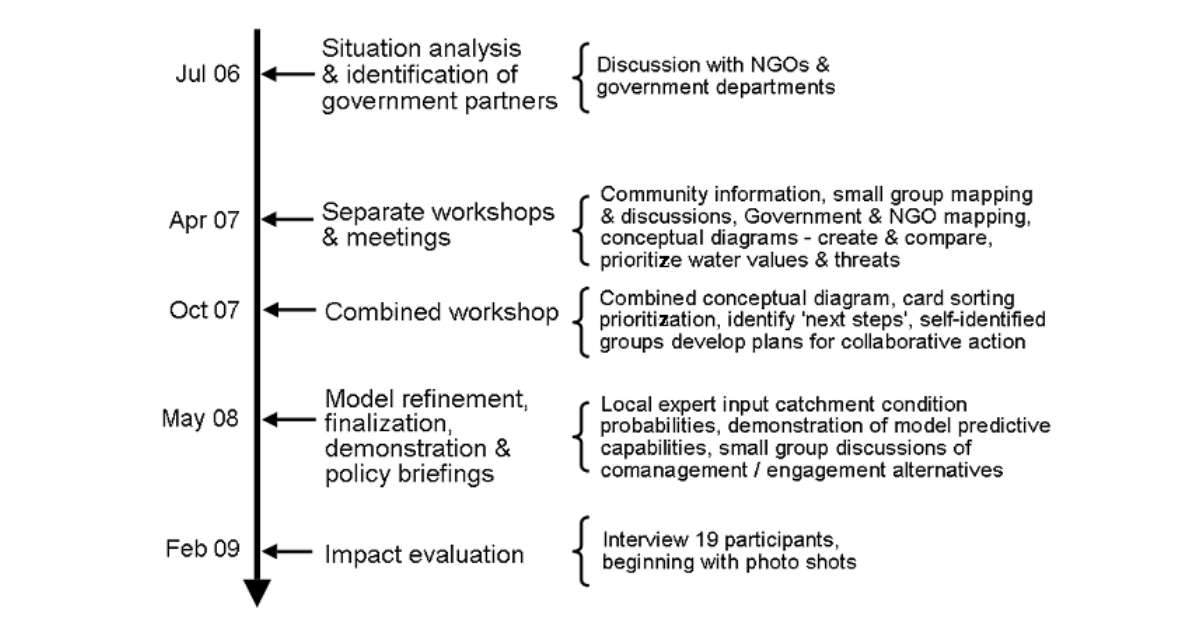
Fig. 1. Research stages and time